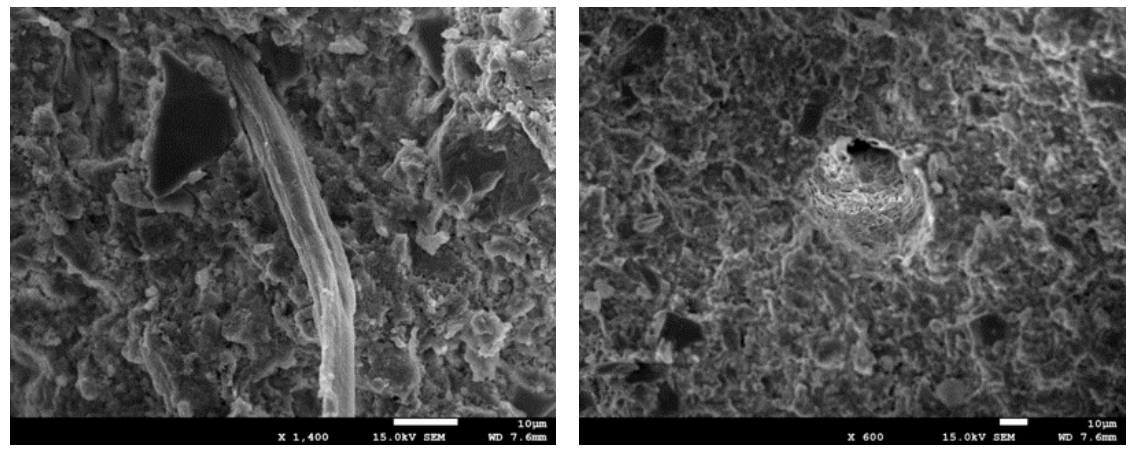
Figure 17: SEM image of different failure phenomenon of PVA fibers in